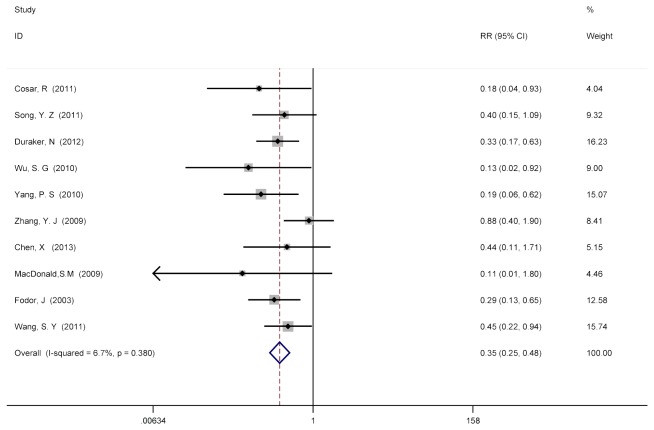
No PMRT versus PMRT after mastectomy surgery for T1/T2, N1-3+ patients on LRR.To investigate the role of PMRT in T1/T2, N1-3+ patients, LRR incidence was initially calculated as a function of PMRT utilization. The overall pooled RR of LRR risk in patients with PMRT versus no-PMRT from the 10 trails was 0.348 (95% CI = 0.254 to 0.477). Significant reporting bias (Begg’s p = 0.152; Egger’s p = 0.107) or heterogeneity between studies (Cochran’s p = 0.380; I2 = 6.7%) were not detected in these 10 studies[11,12,17-24].